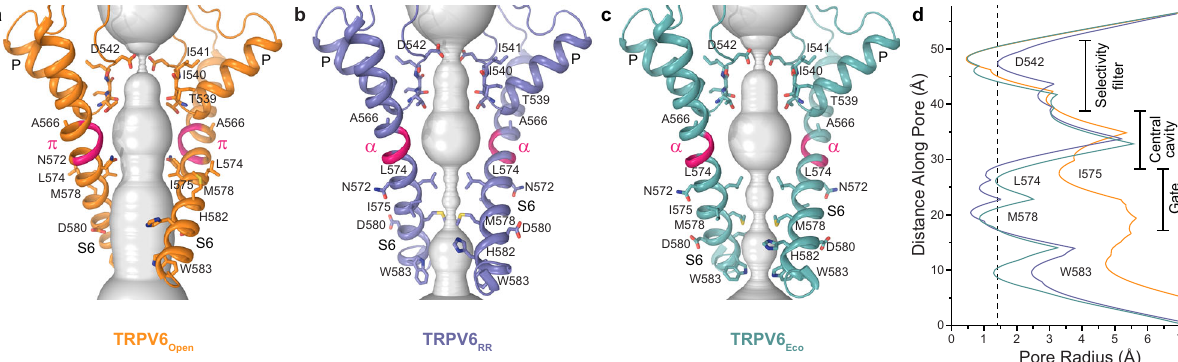
Fig. 5 Ion channel pore. a – c Pore-forming domains in the open ( a ), RR-bound ( b ), and econazole-bound ( c ) states with the residues lining the pore shown as sticks. Only two of four subunits are shown, with the front and back subunits omitted for clarity. The pore pro fi les are shown as space- fi lling models (light gray). The region that undergoes α -to- π transition in S6 is highlighted in pink. d Pore radius for TRPV6 structures calculated using HOLE. The vertical dashed line denotes the radius of a water molecule, 1.4 Separation of Q473 and R589 results in breakage of the salt bridge What remains a puzzle is why RR, which binds at the selectivity fi lter and physically occludes this region of the pore for ion connecting these residues in the open state 55 . The loss of this salt bridge, which energetically compensates for the unfavorable α -to- conductance, also causes the gating transition in the lower pore π transition in S6, reverses the transition. Concurrently, the lower similar to econazole. The selectivity fi lter conformations in portions of S6 helices rotate by ~100°, leading to the separation of TRPV6 RR , TRPV6 Eco , and TRPV6 Open are nearly identical, as well as of the P-helix that directly contacts S6. We hypothesize that the D489 and T581 and the loss of the open-state-stabilizing positive charge of RR creates an electric fi eld inside the pore ’ s hydrogen bond between them 55 . The rotated lower portions of central cavity that interacts with the electric dipole of the S6 helix S6 expose the side chains of L574 and M578 towards the pore (Fig. 6a). This interaction causes repulsion of the lower portion of center and hydrophobically seal the pore to prevent ion con- S6 away from RR, which results in partial S6 rotation and helps ductance, thus converting the channel into the closed, non- S6 to become completely α -helical, with side chains of L574 and conducting state (Figs. 3, 5, and 6).